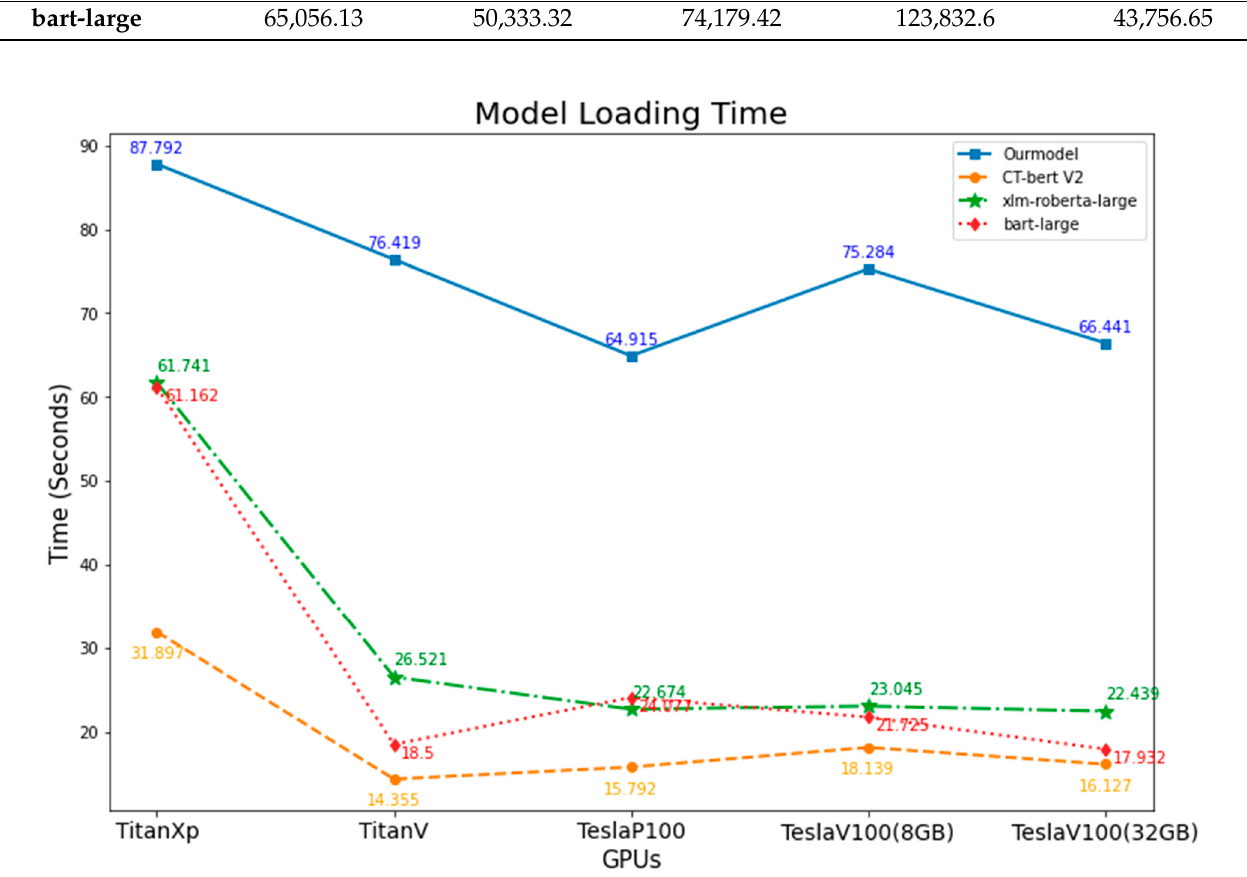
Figure 5. Comparison of models’ loading time on different GPUs.